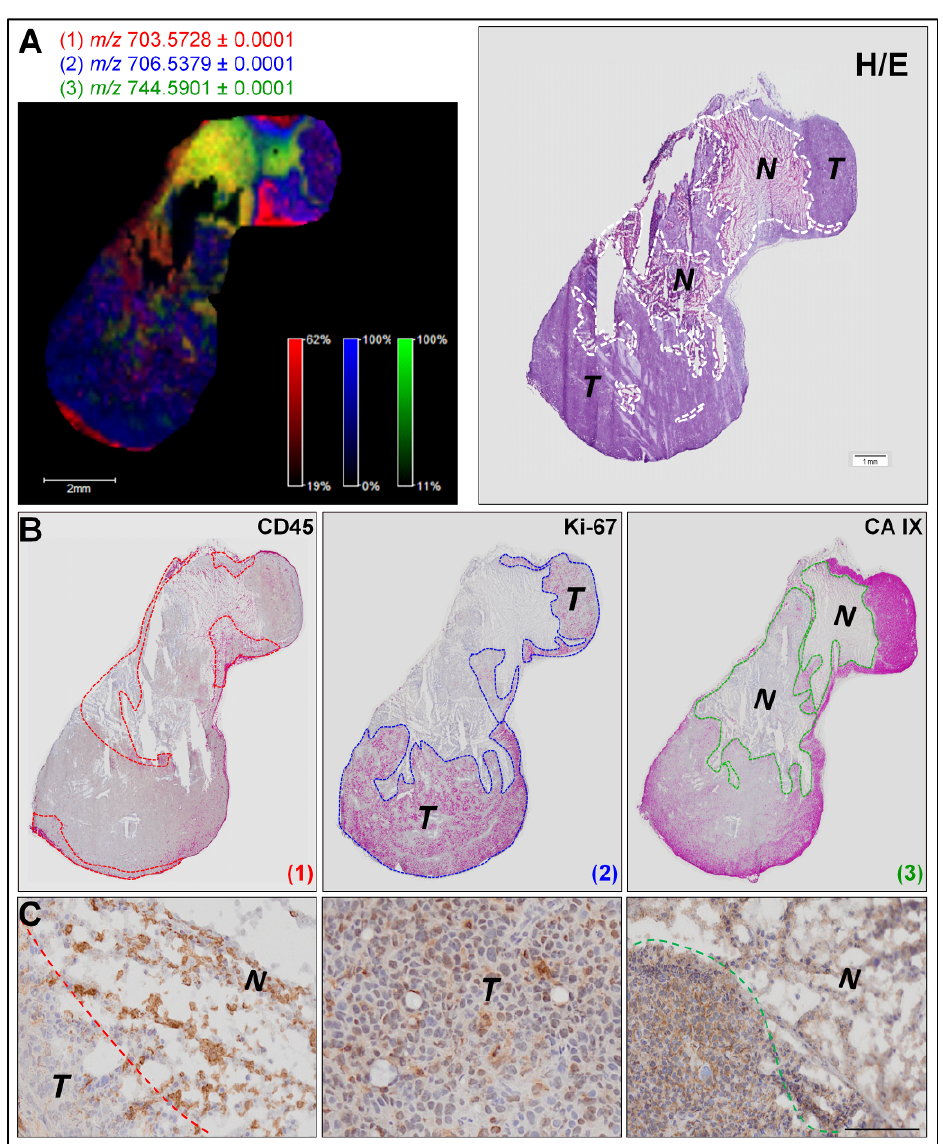
Figure 3. Determination of low-abundant PL species associated with different tumor compartments by correlation between MALDI MSI data and histochemical stainings. ( A ) MALDI MSI ion image representing the localization of three PLs ( m/z values of 703.5728 in red, 706.5379 in blue, and 744.5901 in green) in a section of tumor induced by MDA-MB-435 cells (right panel) and hematoxylin/eosin staining (left panel). Dotted lines on the hematoxylin/eosin stained section image delineate necrosis “ N ” and tumor “ T ” areas; ( B ) Binary images of CD45 (left panel), Ki-67 (central panel) and CA IX (right panel) immunostainings of MDA-MB-435 serial tissue sections. Dotted lines of each binary image delineate the localization of PL ( 1 ) ( m/z 703.5728 in red); PL ( 2 ) ( m/z 706.5379 in blue) and PL ( 3 ) ( m/z 744.5901 in green) shown in ion image. Squares indicate positions of high magnification microscopy images of immunohistochemistry ( C ); and ( C ) High magnification microscopy images of immunohistochemistry for CD45 (left), Ki-67 (middle) and CA IX (right) immunostainings (scale bars, 500 μ